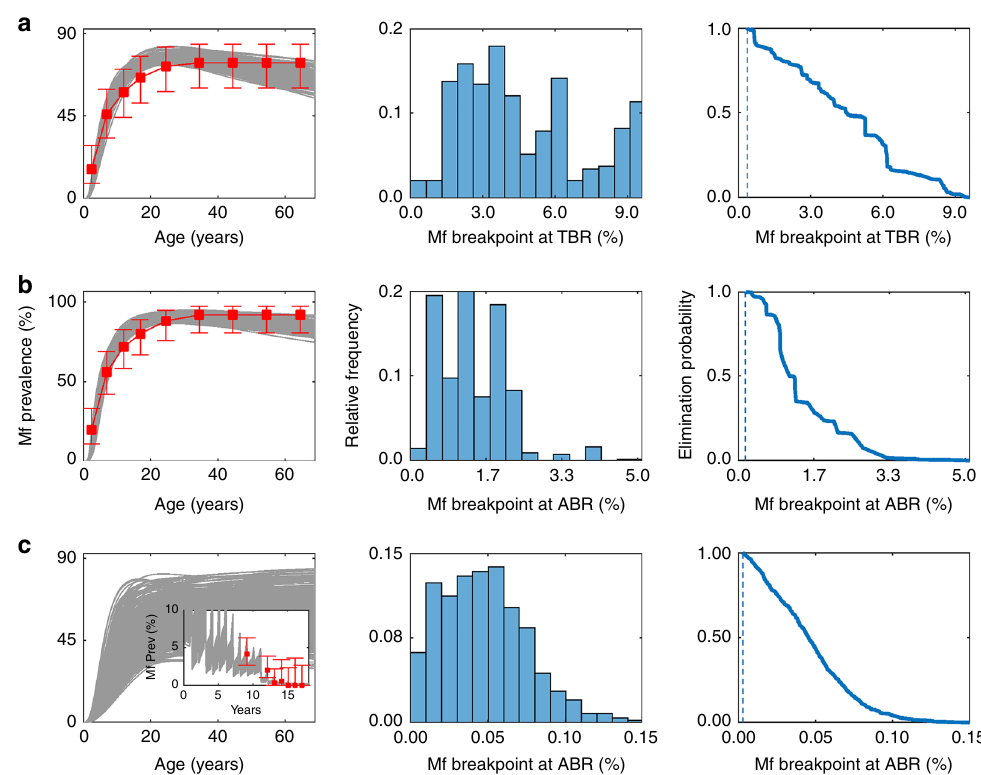
Fig. 1 Model fi ts and estimated transmission breakpoints. The model fi ts (grey curves) to baseline micro fi lariae prevalence from two onchocerciasis endemic sites, a Buriri, Uganda and b Masaloa, Uganda, and one LF endemic site c Gbuwhen, Nigeria, are shown. For Buriri and Masaloa, age-strati fi ed Mf prevalence patterns (shown in the fi gure as red squares for estimated plateau-type patterns with error bars representing the 95% binomial con fi dence intervals) used for fi tting were constructed according to the reported community-level Mf prevalence (Tables 1, 2). For Gbuwhen, the model was fi t to post- intervention data (shown in the inset plot as red squares with error bars representing the 95% binomial con fi dence intervals) and the baseline curves were hindcasted. The distribution of the model-calculated Mf breakpoints (centre) and the corresponding inverse ECDFs (right) are shown for sites a – c . The vertical dashed lines in the inverse ECDF plots denote the Mf breakpoint values corresponding to the 95% elimination probability thresholds applicable in each